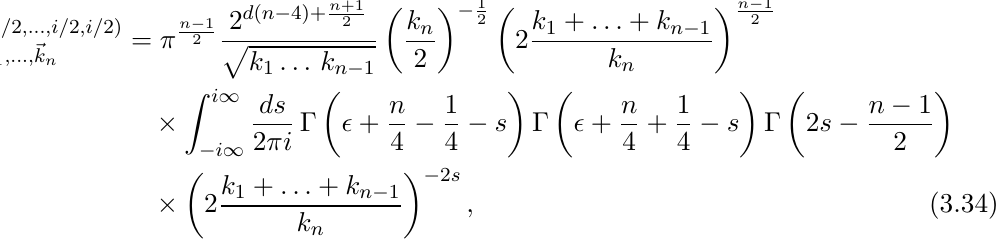
(cid:0) d (cid:1) (cid:6) i(cid:23) n (cid:0) s (in blue) move along the real axis while the poles 4 2 (cid:0) 1 these poles collide and the contour separating 2